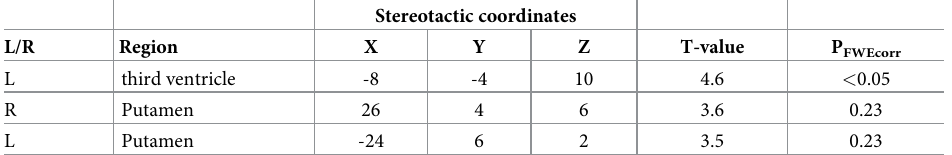
Table 5. SPM analysis of the negative correlation of normalized 2-[ 18 F]FDG uptake to CAPs score in premanifest HD gene-expansion